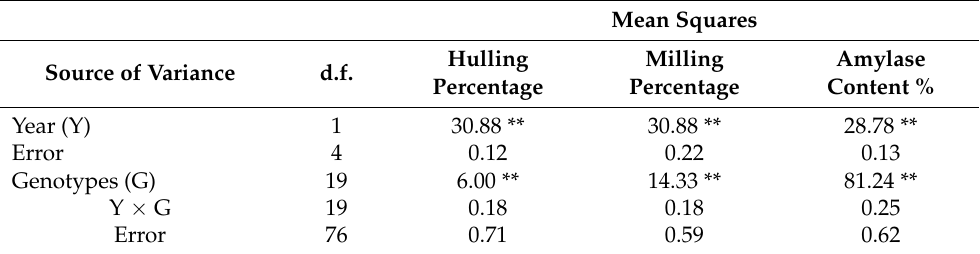
Table 8. The combined analysis of grain quality traits of twenty rice genotypes over the two